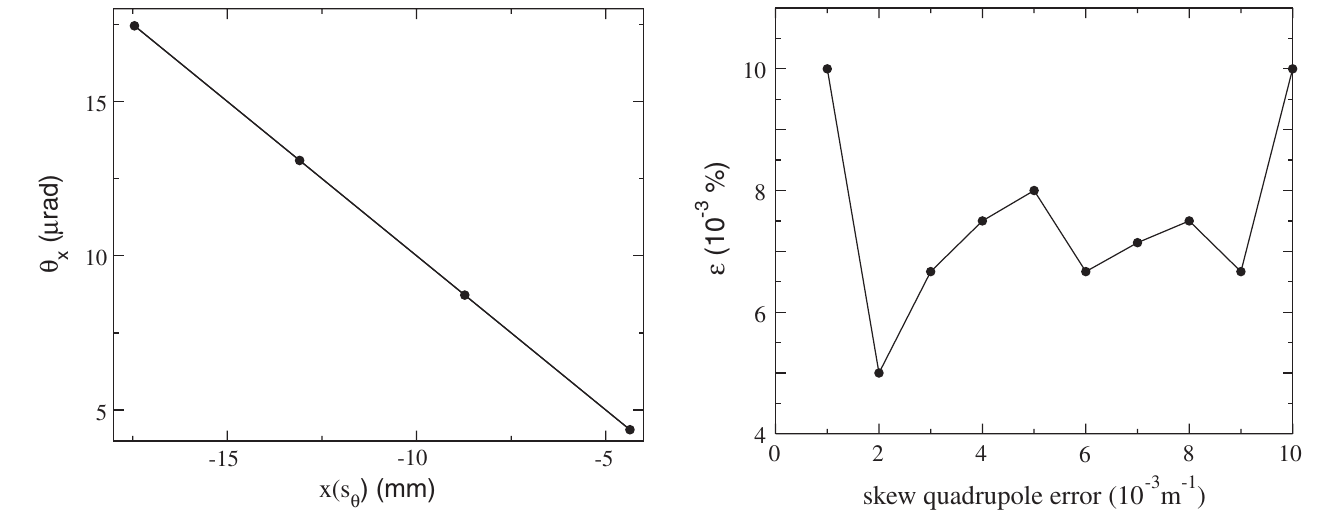
FIG. 3. The measured horizontal quadrupole kick error (cid:1) as a FIG. 5. Simulations predict that the action and phase jump x Þ , in function of the horizontal position of the particle x ð s method determines skew quadrupole errors within an uncertainty (cid:1) response to a gradient error of 1 (cid:5) 10 (cid:1) 3 m (cid:1) 1 intentionally as small as 0.01%. ¼ 1241 m . The slope of the curve, introduced in the lattice at s (cid:1) (cid:1) 0 : 999 69 (cid:5) 10 (cid:1) 3 m (cid:1) 1 , is very close to the expected value.